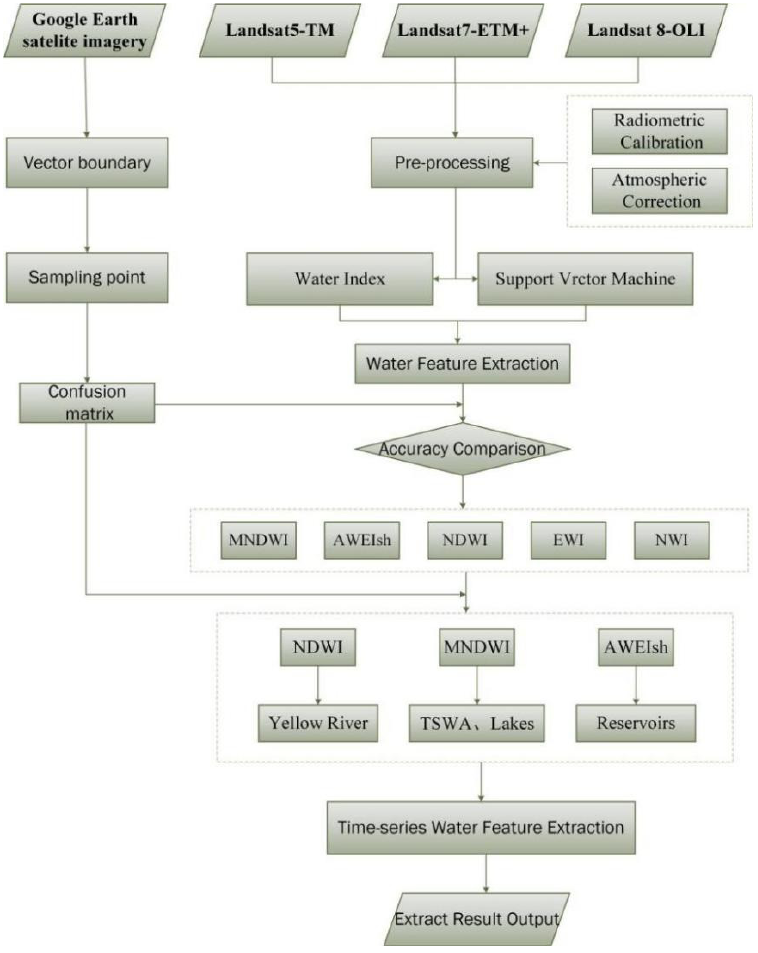
Figure 1. Workflow diagram.